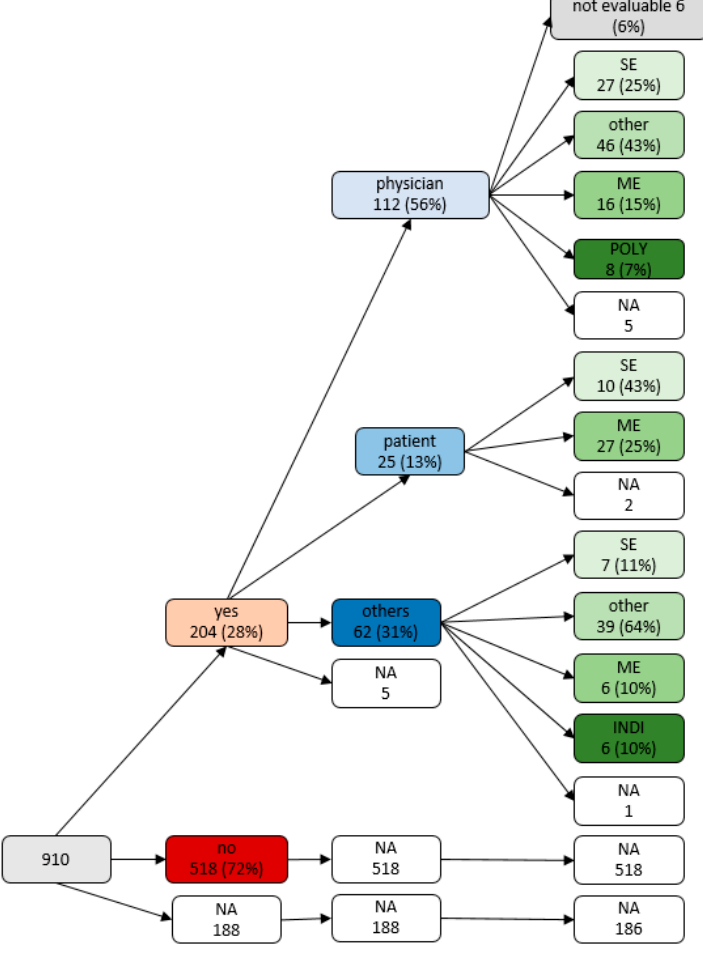
Figure 2. Variable tree: initiator with their different reasons for changes of medication after dis- charge, note: NA = not available, INDI = new indication, ME = missing effects, SE = side, effects, POLY = polymedication.